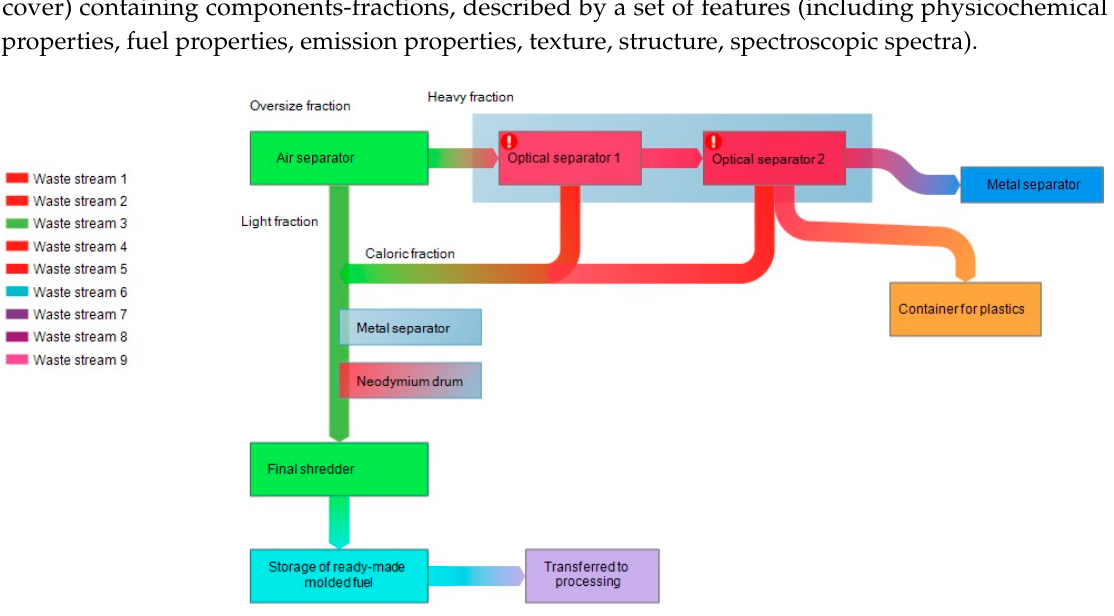
Figure 4. Block diagram of the ballistic and optical separation processes separated from the technological line[own elaboration].